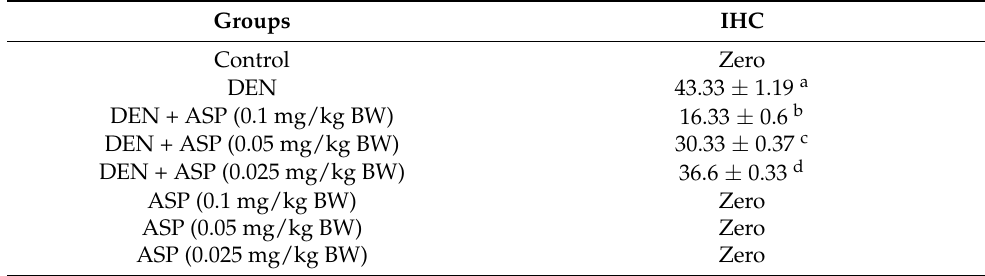
Table 5. Scoring summary of GST-P immunolabelling in different experimental groups in the liver tissues in a rat model.